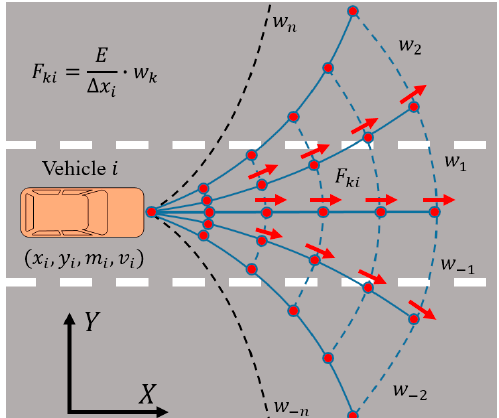
Figure 3. The setting of weights according to the HMM algorithm. It’s going to be challenging to solve for 𝑆 (cid:3047) if we set the value of 𝑛 too large. However, to make the calculation of equivalent force more accurate, we need to set the increment of steering angle more closely. So as long as the corresponding steering angle in the corresponding interval is (𝛿 (cid:3038)(cid:2879)(cid:2869) ,𝛿 (cid:3038) ] or [𝛿 (cid:2879)(cid:3038) , 𝛿 (cid:2879)(cid:3038)(cid:2878)(cid:2869) ) , the weight will take 𝑤 (cid:3038) or 𝑤 (cid:2879)(cid:3038) .